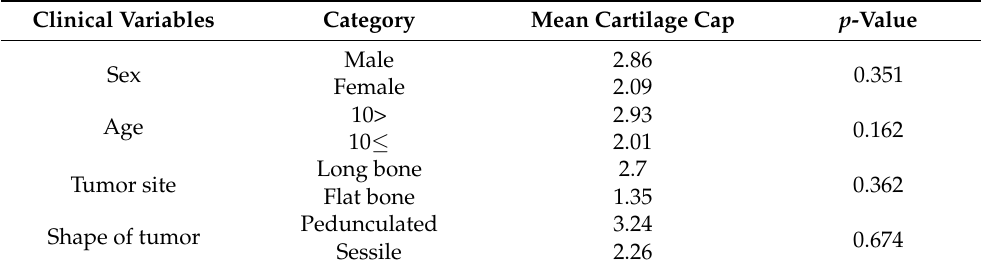
Table 4. The relationship between cartilage cap and clinical variables.